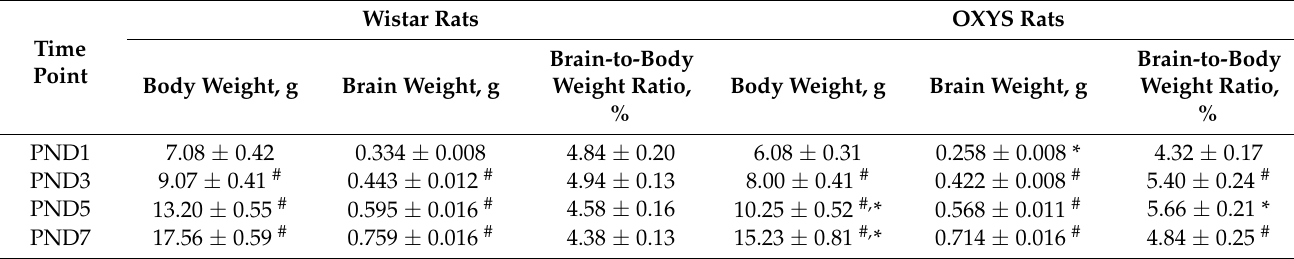
Table 1. Body and brain weight and the brain-to-body weight ratio in OXYS and Wistar